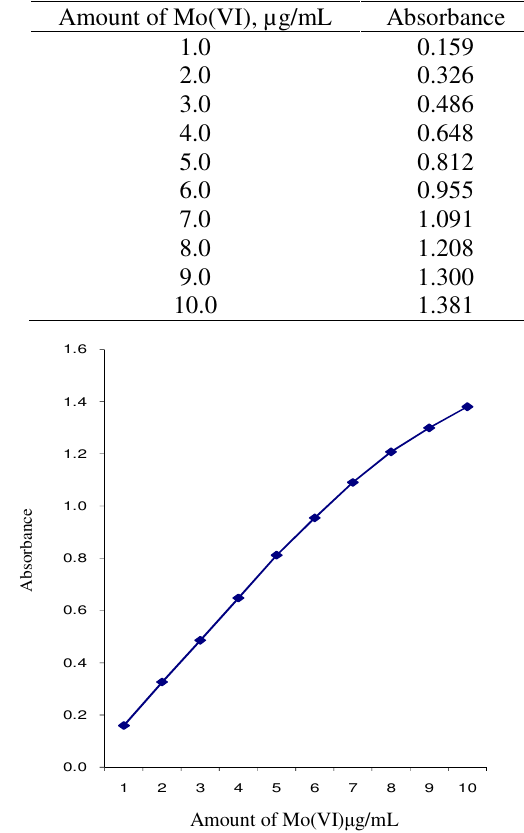
Figure 3. Validity of Beer’s law on Mo(VI)-GPPH complex Ringbom plot for Mo(VI)-GPPH